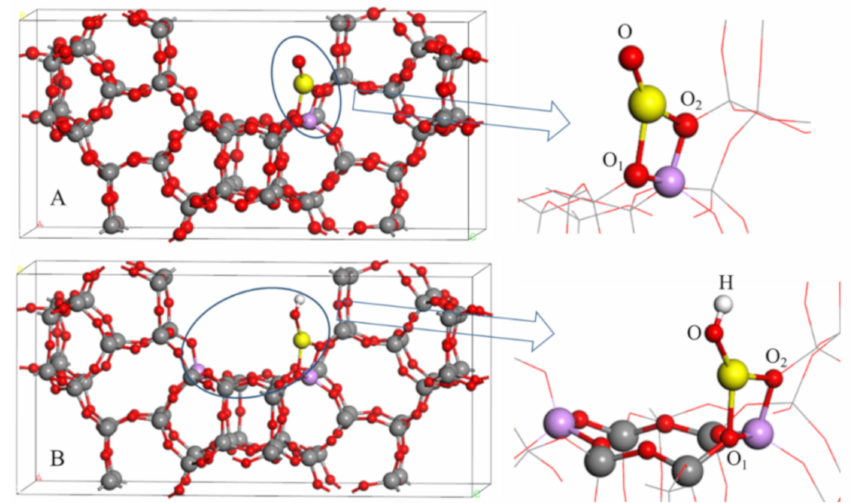
Figure 1. Optimized periodic structure illustrations of In / BEA unit cell. ( A ) L-model of In / BEA; ( B ) B-model of In / BEA. Grey, red, purple and yellow balls represent Si, O, Al, and In atoms, respectively, and this color scheme will be used throughout.